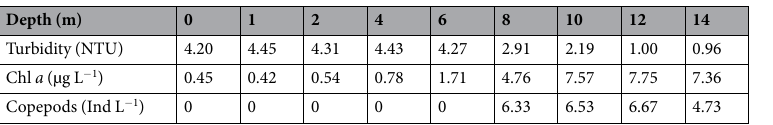
Table 2. Changes in turbidity, Chlorophyll a (Chl a ), and copepod abundance ( Cyclops abyssorum tatricus copepodid CI to adult life stages) with depth in Lake FAS3 in July